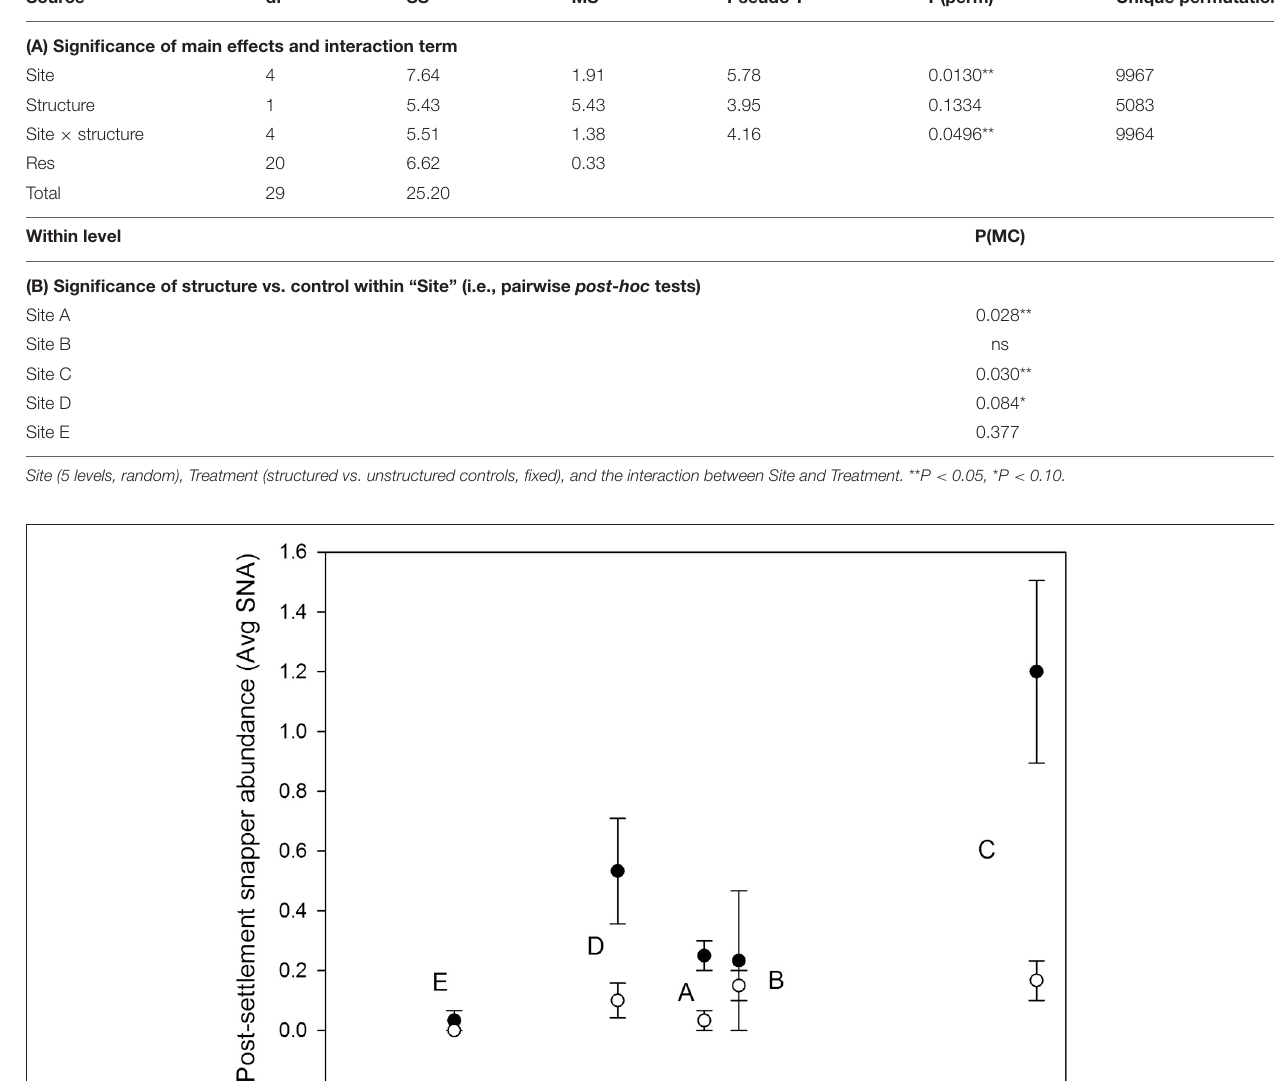
TABLE 2 | Effects of experimentally added structure on the abundance of post-settlement snapper (Avg SNA), assessed using non-parametric permutational multivariate analysis of variance (PERMANOVA, Primer 7). Source df SS MS Pseudo-F P(perm) Unique permutations